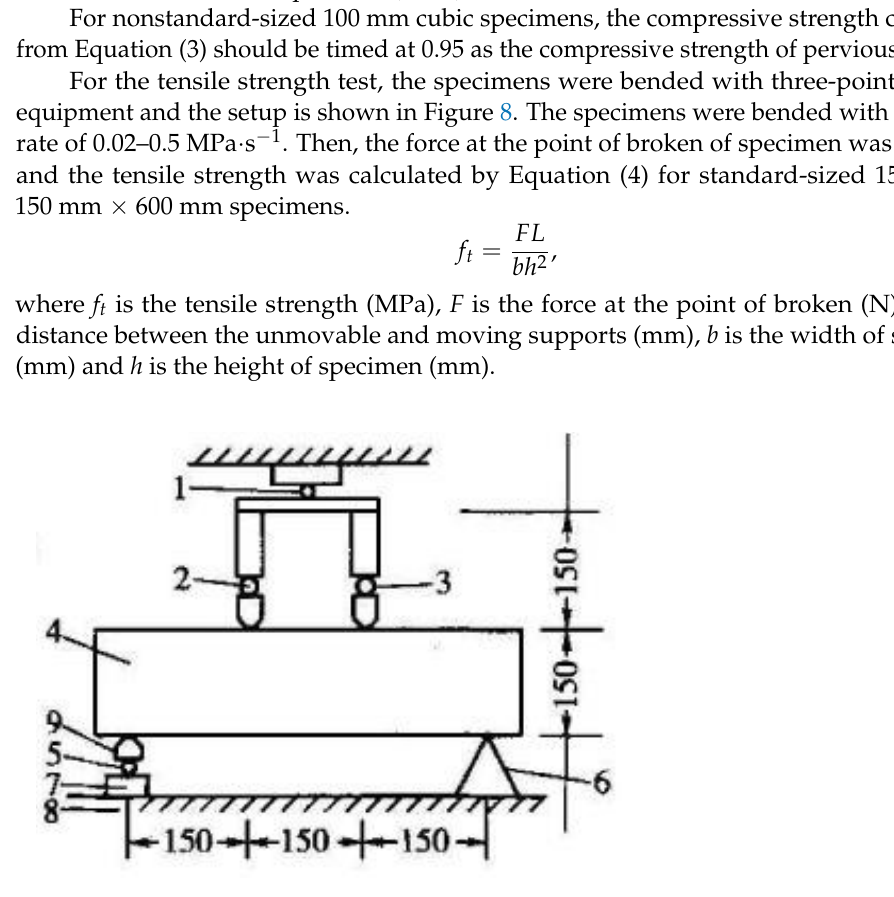
Figure 8. Setup of tensile strength test for standard-sized specimens, where 1 and 2 are single steel balls, 3 and 5 are double steel balls, 4 is the specimen, 6 is the unmovable support, 7 is the moving support, 8 is the bottom of equipment and 9 is the moving support.